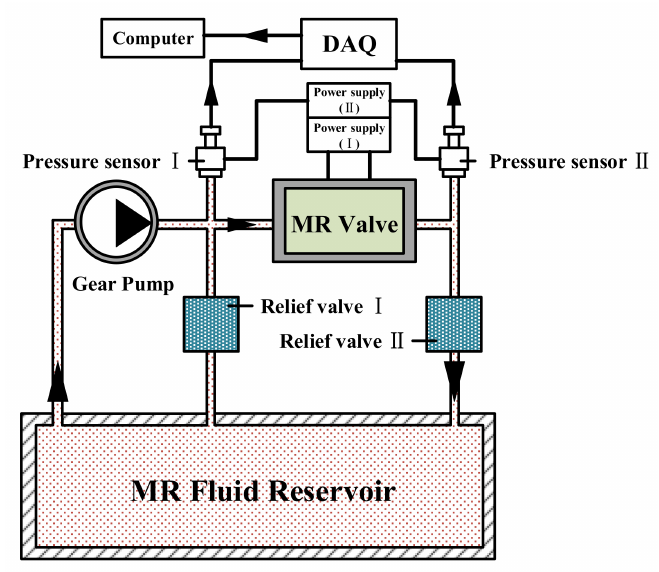
Figure 10. Schematic diagram for experimental setup of the proposed MR valve.